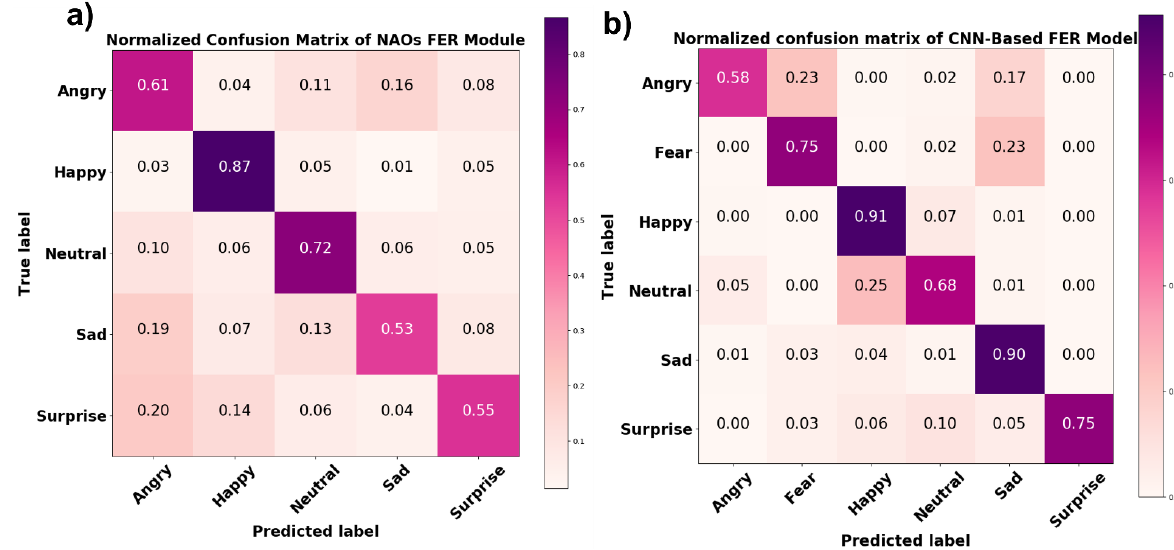
Figure 10. Normalized confusion matrix of ( a ) NAO’s FER module and ( b ) the CNN-based FER model tested on experimental data. Table 1. Precision, recall, and F1 score achieved by NAO’s FER module on the experimental data for each output class compared to those of the CNN-based FER module. The best performances are highlighted in bold.